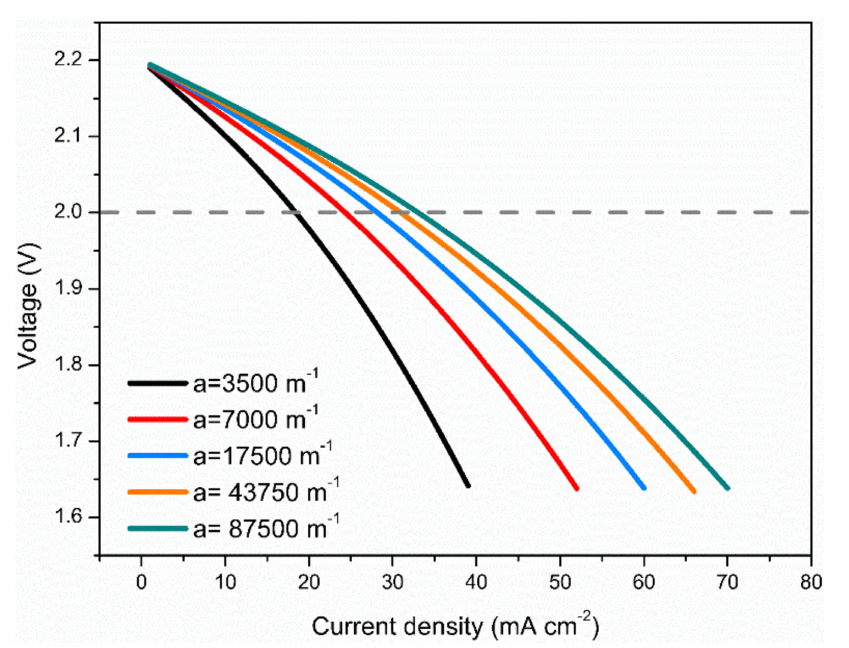
Figure 6. Effect of different electrode specific surface areas. Electrolyte: 100 mM V(acac) 3 in 500 mM TEABF 4 ; SOC: 50%; flow rate: 25 mL min − 1 ; temperature: 300 K.